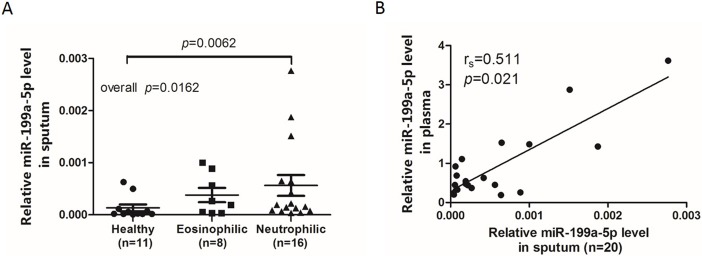
Relative miR-199a-5p levels in sputum in different groups.(A) Normalized miR-199a-5p expression levels in sputum from different inflammatory phenotypes and healthy controls. (B) The correlation between the miR-199a-5p expression levels in plasma and sputum. Data are presented as dot plots with fitted regression lines. The miR-199a-5p expression levels were normalized to U6. Spearman R-value and p-value are indicated.